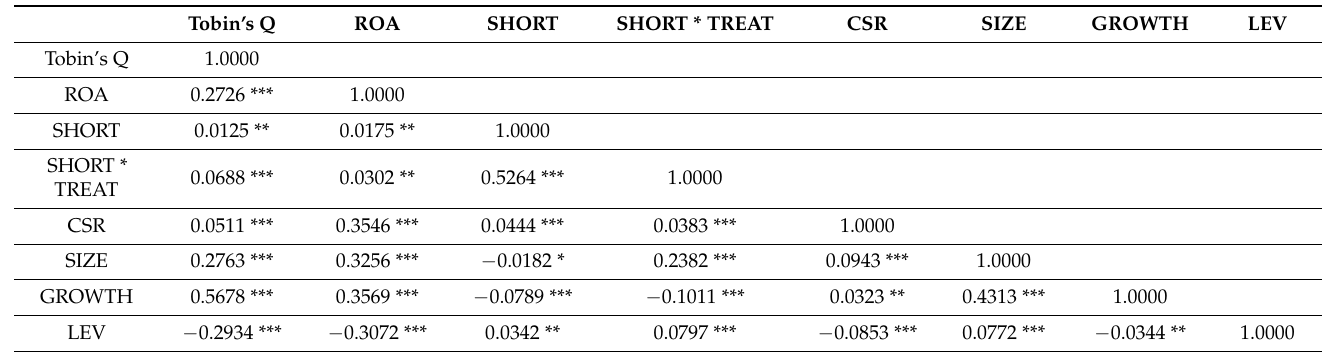
Table 5. Pearson’s correlation matrix.